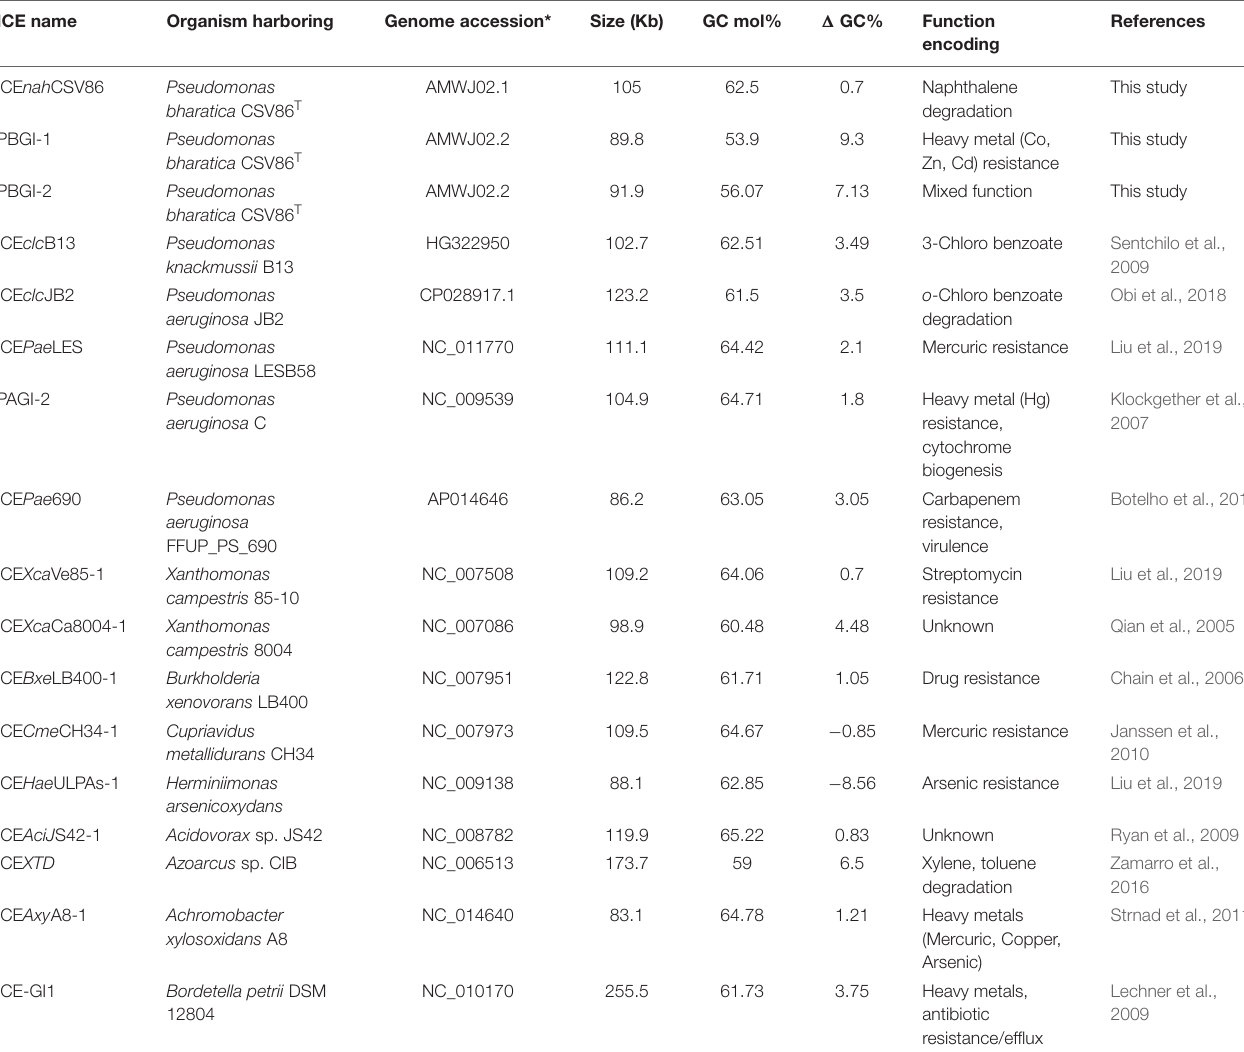
TABLE 1 | Comparative analysis of three GIs, suspected to be ICEs, from Pseudomonas bharatica CSV86 T and syntenic members of ICE clc family used in this